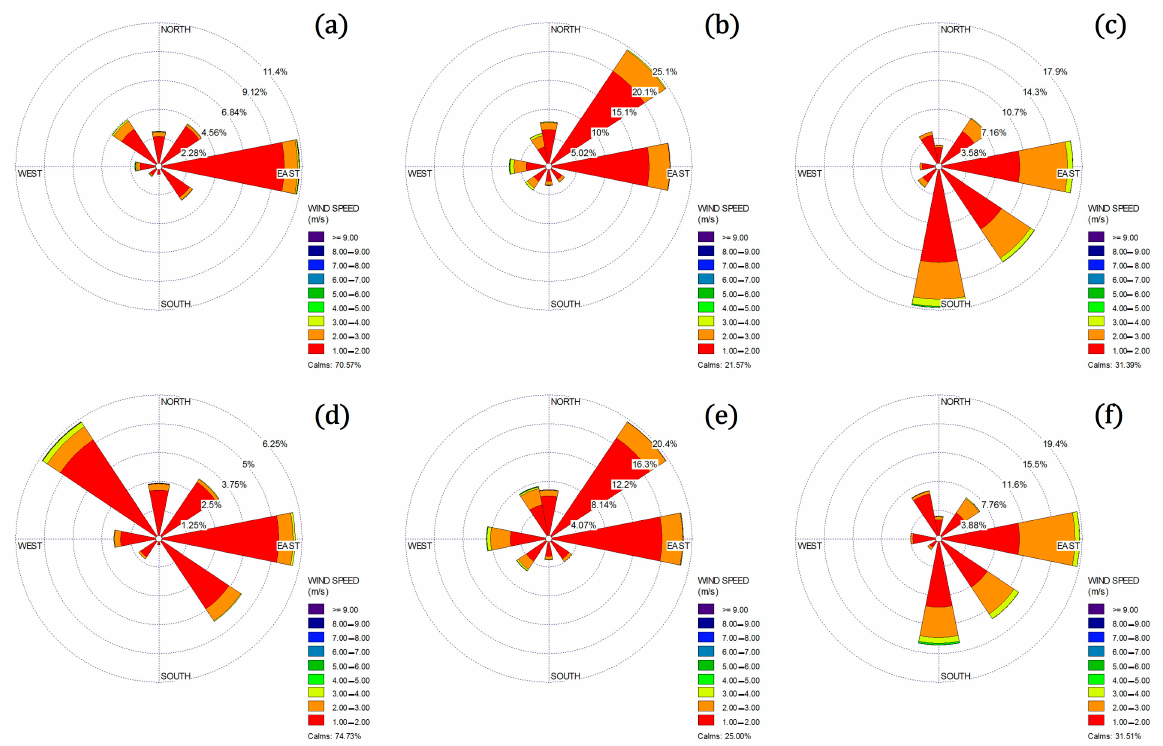
Figure 3. Wind roses with wind speed (m/s) and direction (%) for spring and summer in Castro ( a , d ), Curitiba ( b , e ), and Paranagu á ( c , f ), respectively.